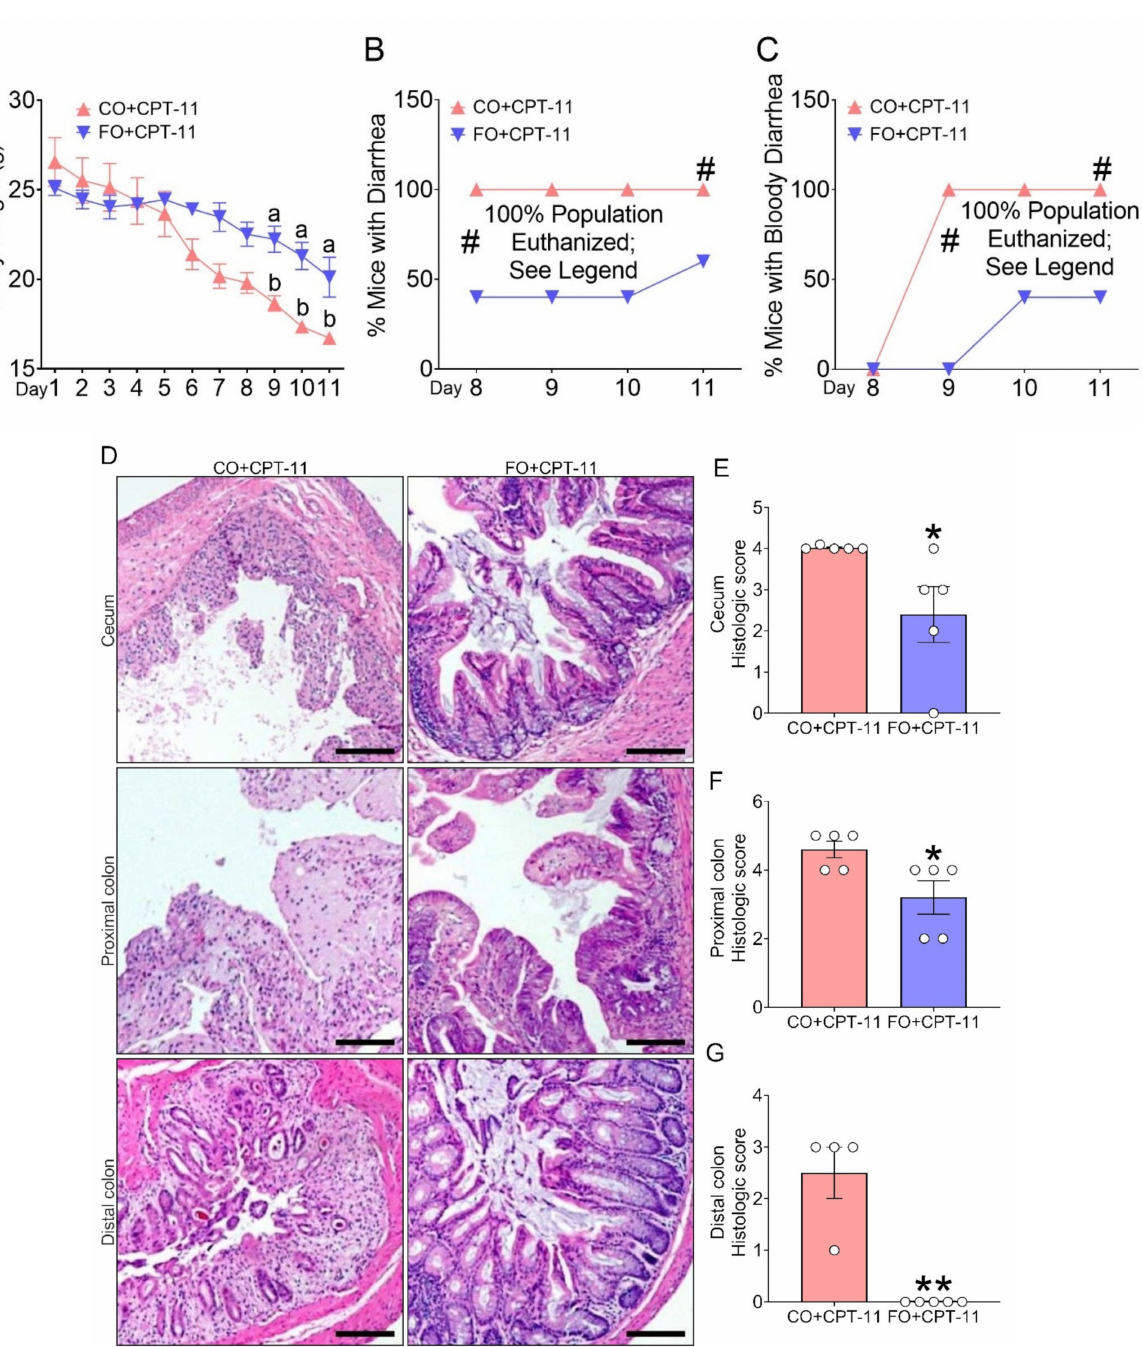
Figure 4. Dietary n-3 PUFA supplementation reduces CPT-11-induced gastrointestinal toxicities . Male, five-week-old wild type (WT) mice were divided into two groups ( n = 5 per group) and were fed omega-6 [10% corn oil (CO)] and omega-3 [5% CO+5% fish oil (FO)] PUFA supplemented diets for two months. These mice were then subjected to nine consecutive days of treatment with intraperitoneal injections (i.p.,) 50 mg/kg CPT-11. ( A ) Bodyweight was monitored every day. ( B ) CPT-11 produced diarrhea starting as well as peaking after eight days in the CO+CPT-11 group. ( C ) CPT-11 produced bloody diarrhea starting after eight days and peaking at nine days in the CO+CPT-11 group, whereas the incidence of diarrhea and bloody diarrhea were reduced in the FO+CPT-11 group. By days 9 to 11, mice in the CO+CPT-11 group began to suffer from severe lethargy and lack of movement; by day 11, all mice in that group were euthanized. ( D ) Large intestinal tissue was sectioned into the ice,